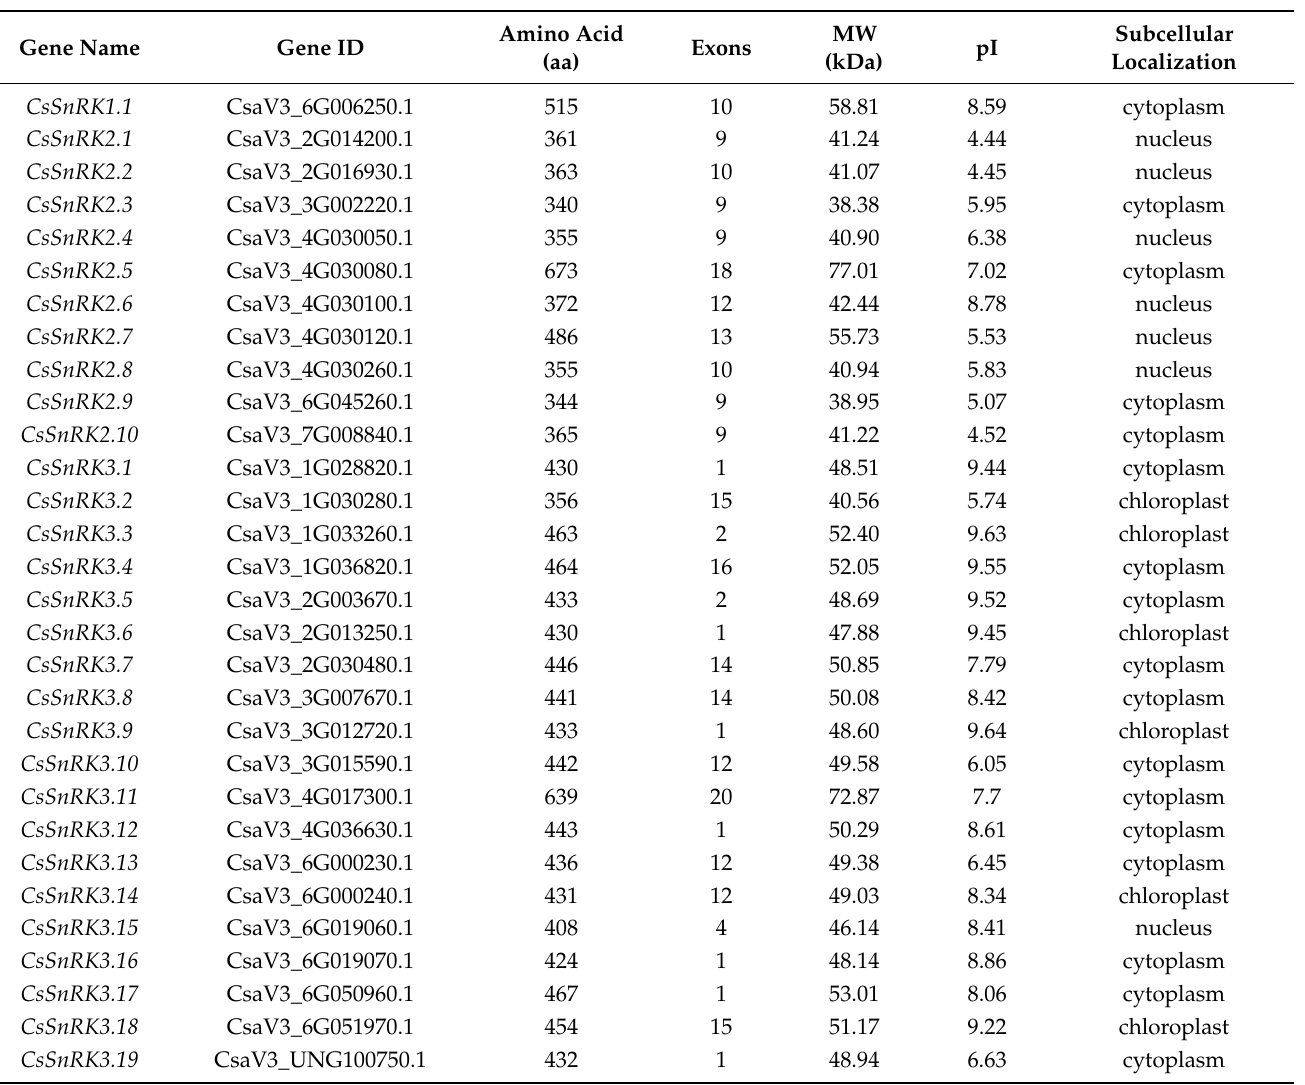
Table 1. The characteristics of the CsSnRK gene family in